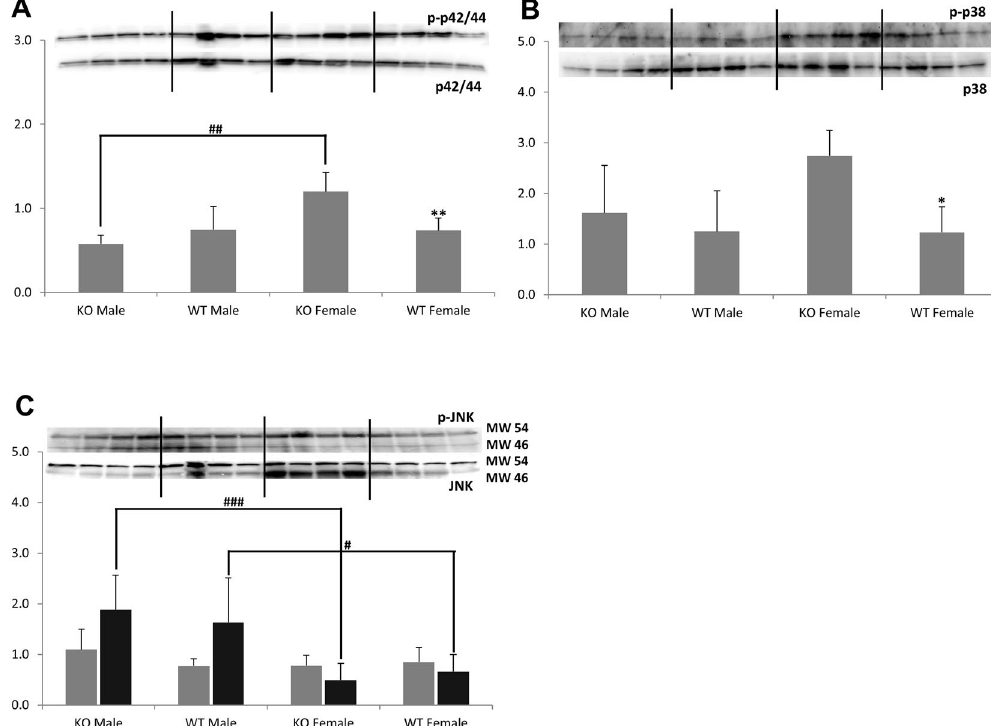
Figure 4. Western blot analysis of MAPK proteins. ( A ) Increased phosphorylation of p42/44 (expressed as phospho-p42/44 at Thr202/Tyr204 to p42/44-ratio) and ( B ) p38 (expressed as phospho-p38 at Thr180/ Tyr182 to p38-ratio) proteins was evident in the kidneys of Ppif − / − females. ( C ) However, a reduction of JNK phosphorylation (phospho-JNK at Thr183/Tyr185 to JNK) was evident in both WT and Ppif − / − females as compared to their respective males (grey bars: band at 54 kDa, black bars: band at 46 kDa). Data is presented as average ± SD (n = 4). One-way ANOVA significances were as follows: ( A ) P = 0.005, ( B ) P = 0.035 and ( C ) P = 0.156 and P = 0.005 for pJNK/JNK 54 kD and 46 kDa forms, respectively. Significance levels are: * p < 0.05 and ** p < 0.01 for WT versus Ppif − / − animals (male and female); # p < 0.05 and ## p < 0.01 for male versus female in WT and Ppif − / − groups.